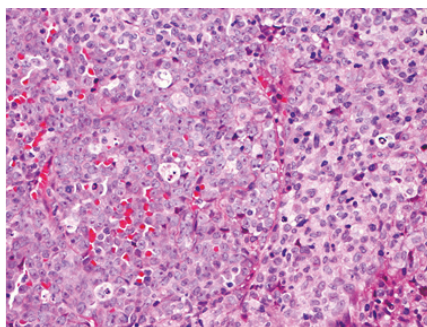
Figure 1: A morphology slide showing many neoplastic cells.